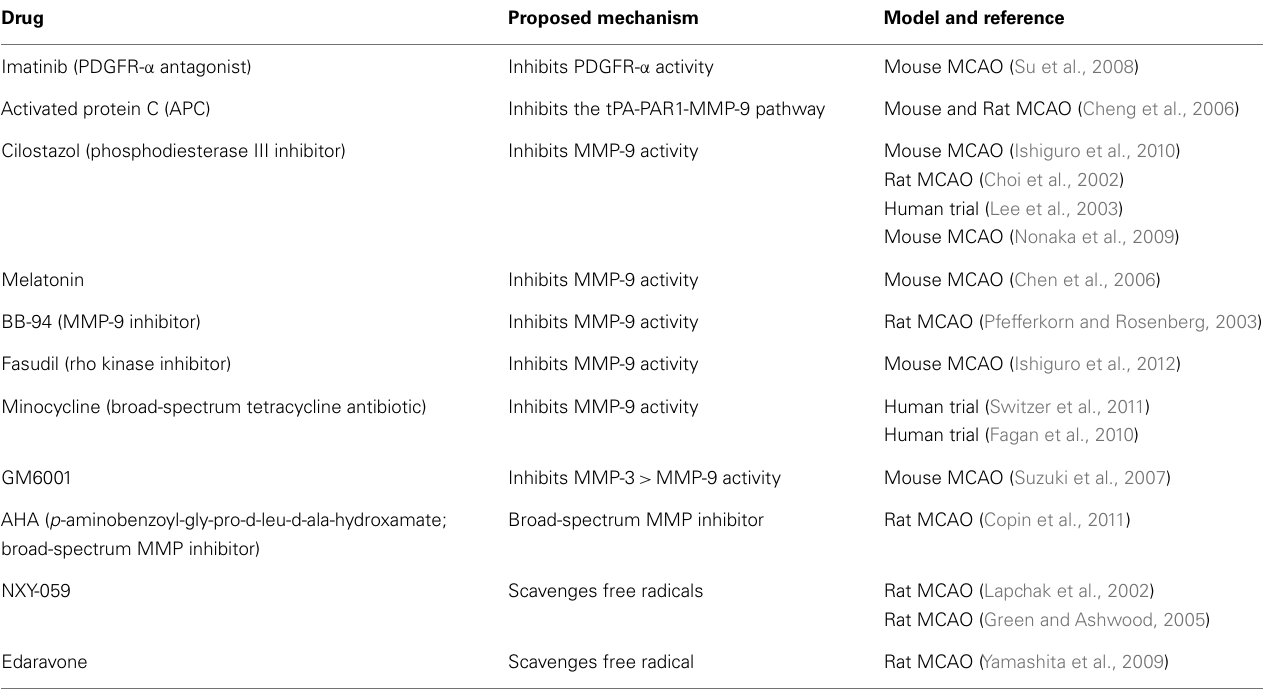
Table 2 | Drugs that can attenuate tPA-related hemorrhagic transformation of ischemic